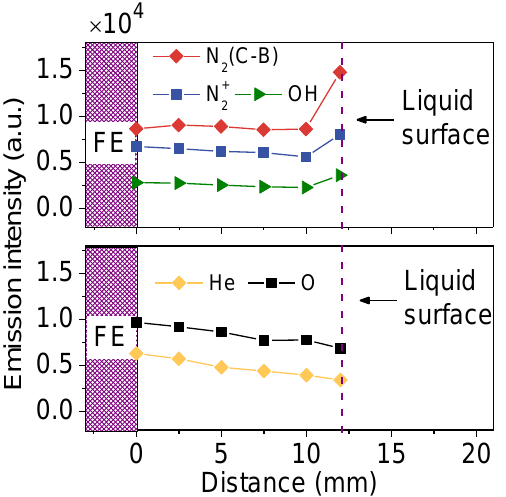
Figure 7. The spatial distributions of N 2 (C 3 Π u → B 3 Π g ), N +